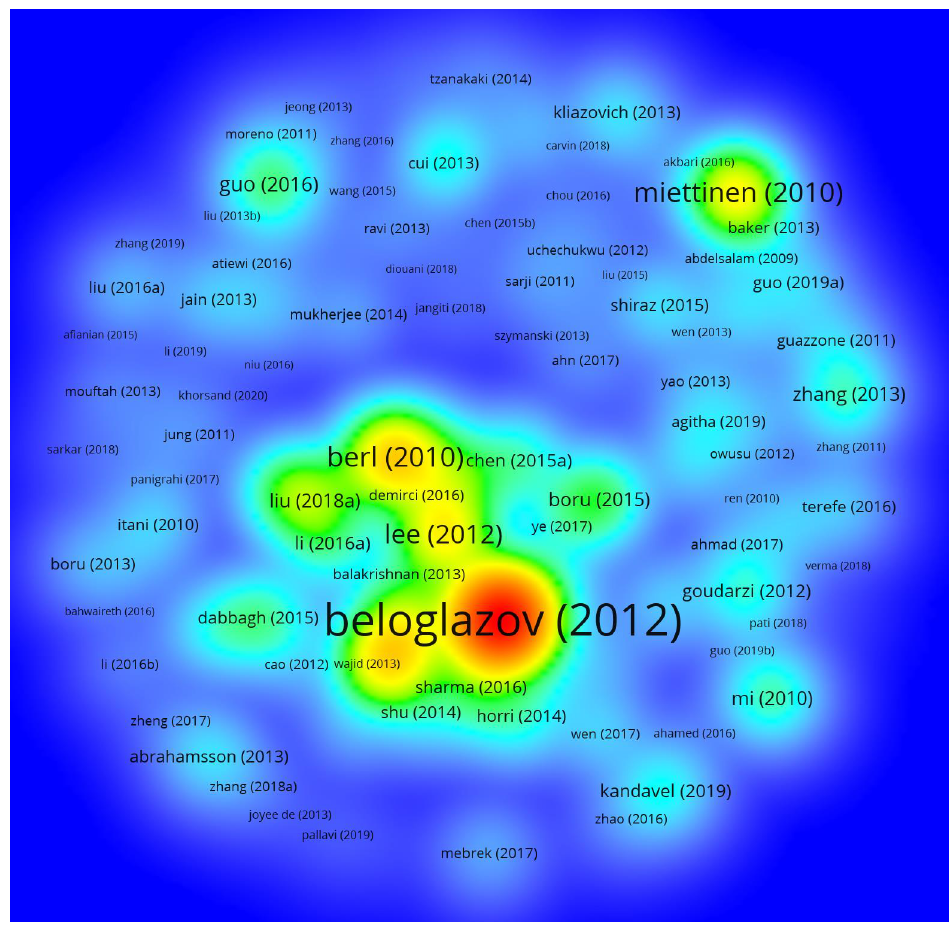
Figure 1. Direct citation analysis of the cloud computing energy efficiency research field (item density visualization; weights —citations). Source: authors’ own study. Data sourced from Scopus, analyzed with VOSviewer (5 September 2020).